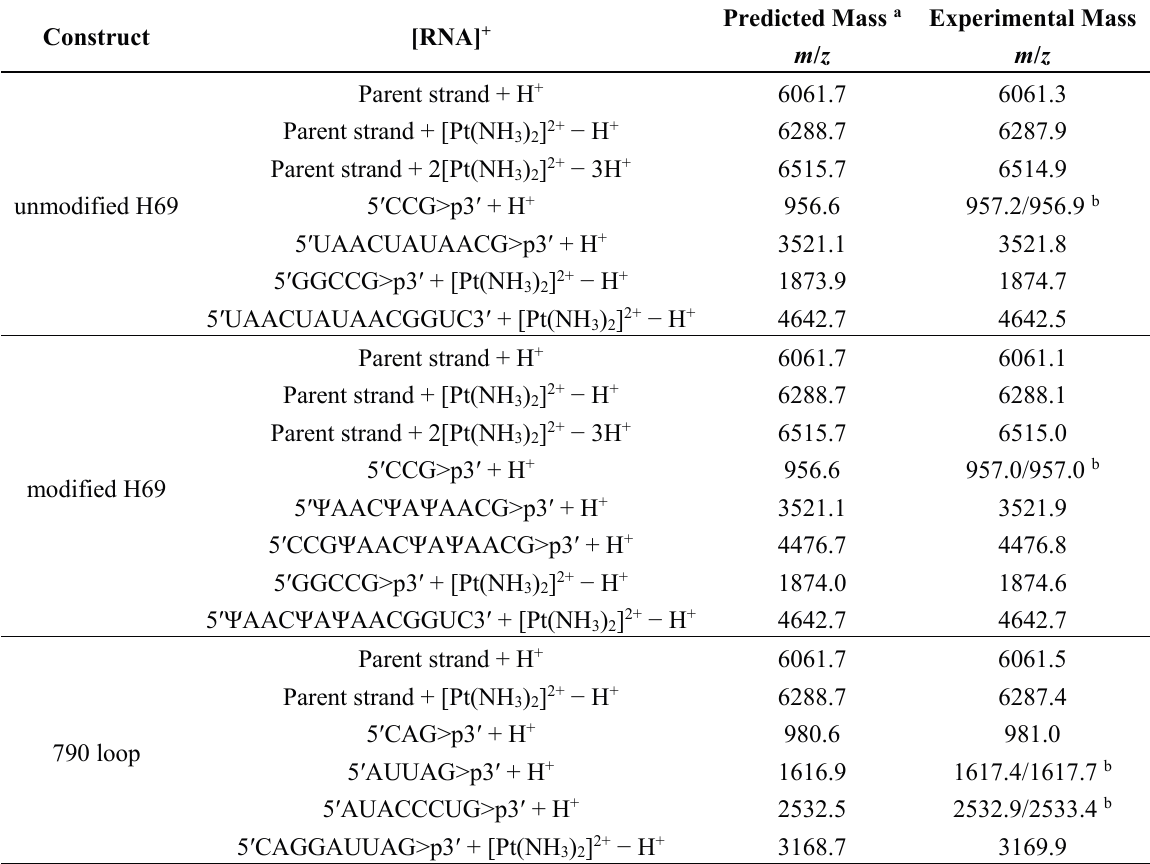
Table 1. Predicted and experimental masses of unmodified H69, modified H69, and 790 loop RNA (parent strands, platinated products, and RNase T1 digestion